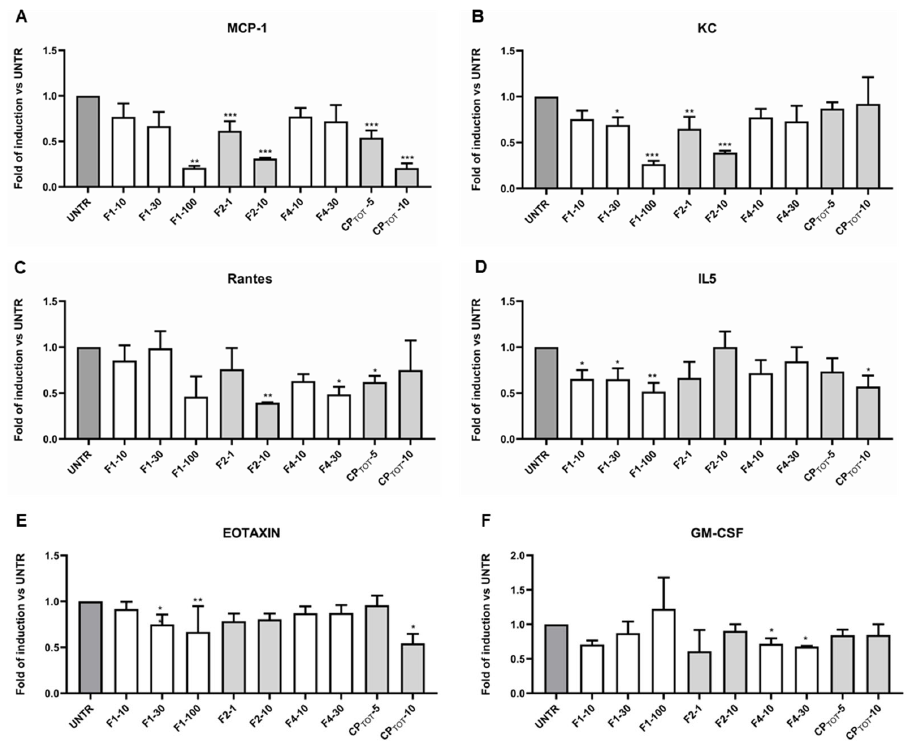
Figure 4. Effect of CP fractions and total extract on inflammatory cytokine release. Extracellular inflammatory cytokine release was evaluated in the culture medium at the end of adipocyte differentiation on 3T3 ‐ L1 cells left untreated (UNTR) or treated with the indicated concentration ( μ g/mL) of fractions 1, 2, or 4 (F1, F2, F4) or of the total extract (CP TOT ). The following cytokines’ modulation are shown: MCP ‐ 1 ( A ), KC ( B ), Rantes ( C ), IL5 ( D ), eotaxin ( E ) and GM ‐ CSF ( F ). Results are expressed as mean ± SEM of at least two independent experiments. * p < 0.05, ** p < 0.01, *** p < 0.001.